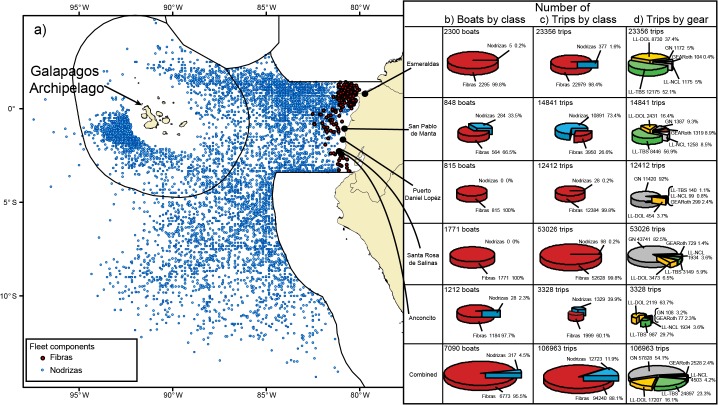
Spatial extent and summary statistics for the Ecuadorian artisanal fishery for large pelagics.(a) Geographical location of longline sets. Blue dots correspond to sets by nodrizas (n = 6,821, 2007–2012; SCM captain logbook records) and red dots to independent fibras (n = 244, 2010–2013; SCM onboard observer records) (see text for fleet component descriptions); (b) number of boats by fleet class in each port (SRP-VMAP-MAGAP 2013 artisanal fishery census data). Summary statistics for the SCM dataset used in this study by fishing port (2008–2012): (c) number of trips by fleet class and (d) number of trips by gear type. LL-DOL: longline gear targeting dolphinfish; LL-TBS: longline gear targeting the tuna-billfish-shark; LL-NCL: unclassified longline gear; GN: surface gillnet; GEARoth: other gear.